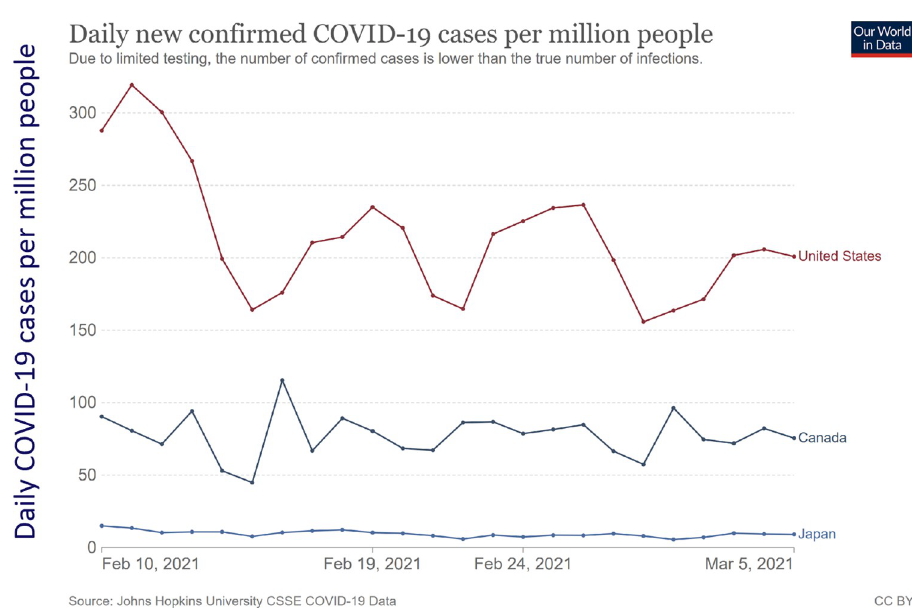
Fig 8. Daily COVID-19 cases per million people by country from February 10 to March 5, 2021. Retrieved from [38], the dataset of which is based on the COVID-19 Data Repository of the Center for Systems Science and Engineering at Johns Hopkins